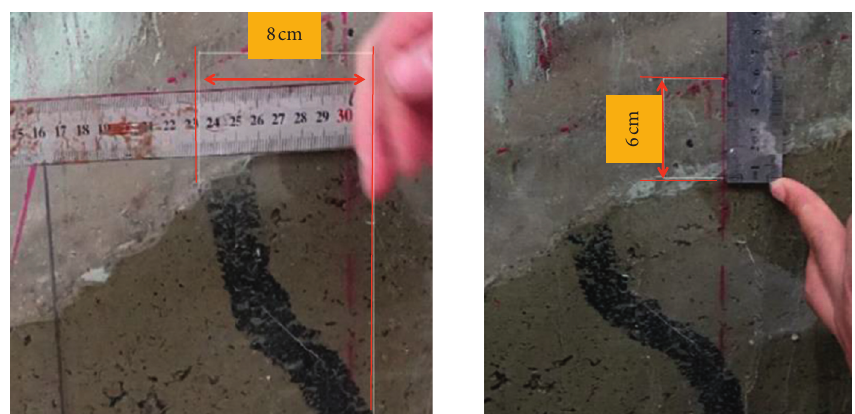
Figure 12: Displacement and settlement change of slope foot